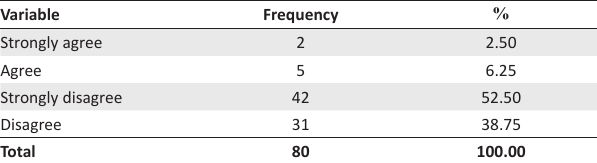
TABLE 5: Managers in the departments are comfortable with the five-point rating